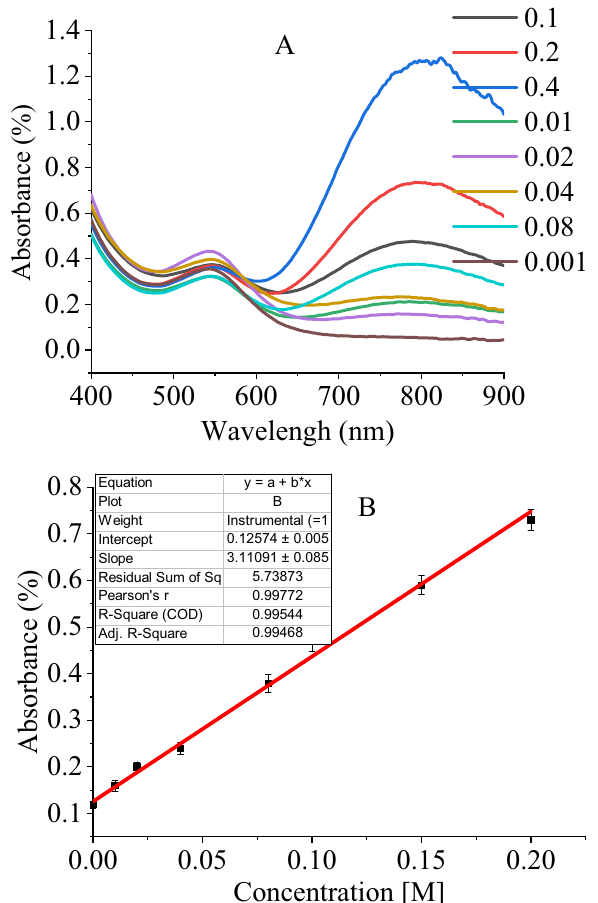
Figure 7. UV–Vis spectrum of GQD-EBT and GQD-EBT-Co 2+ in various concentrations of Cu 2+ at pH = 3 ( A ), and linear range of absorbance in various concentrations ( B ).